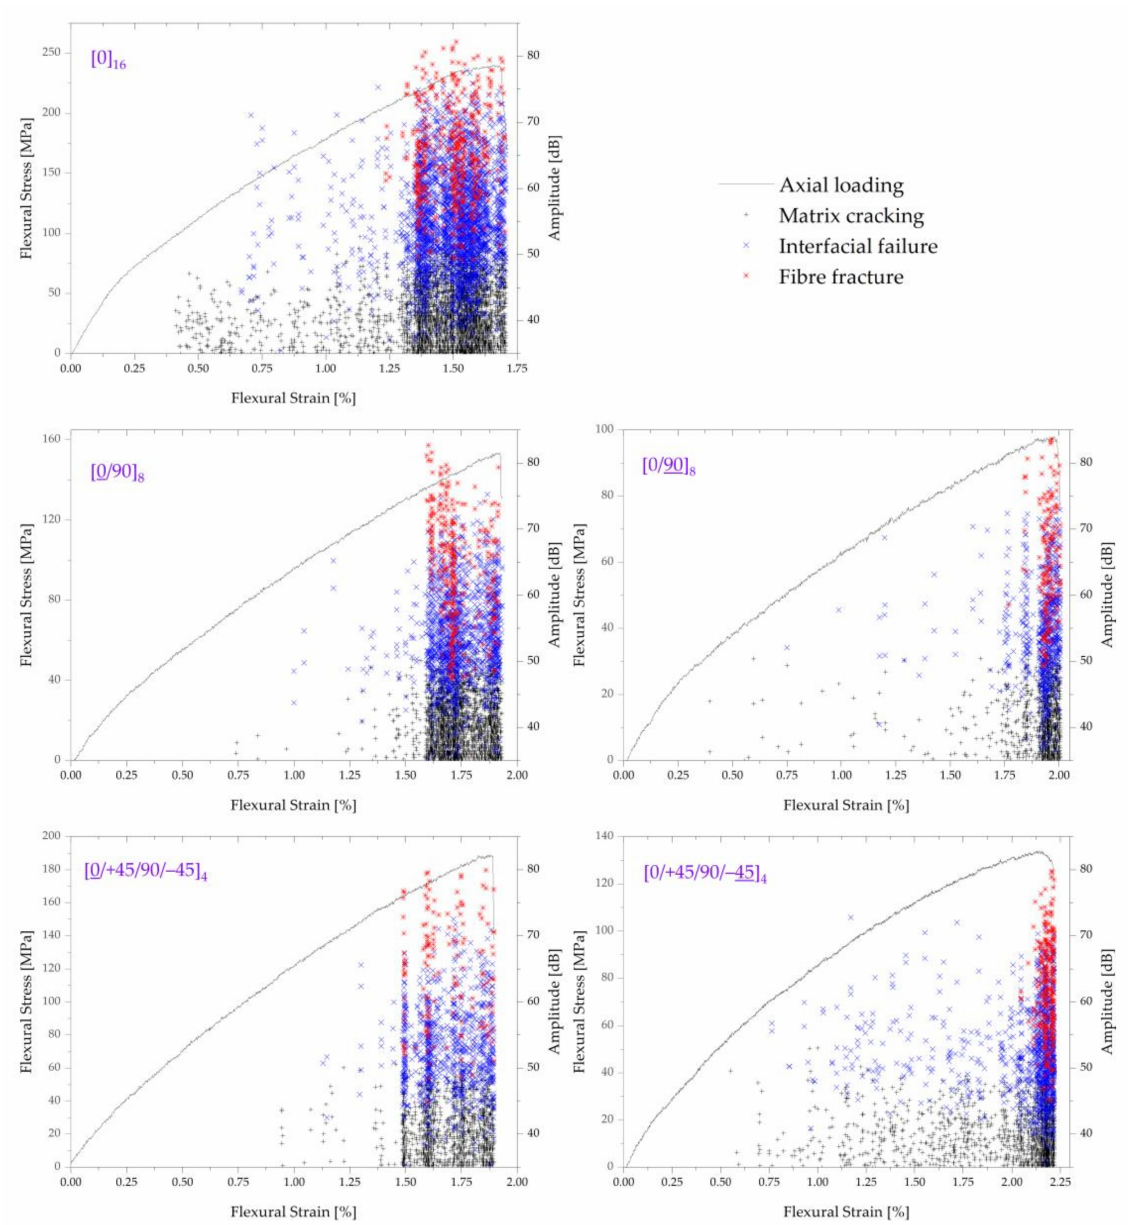
Figure 6. Results of the K-means classification of the acoustic emission